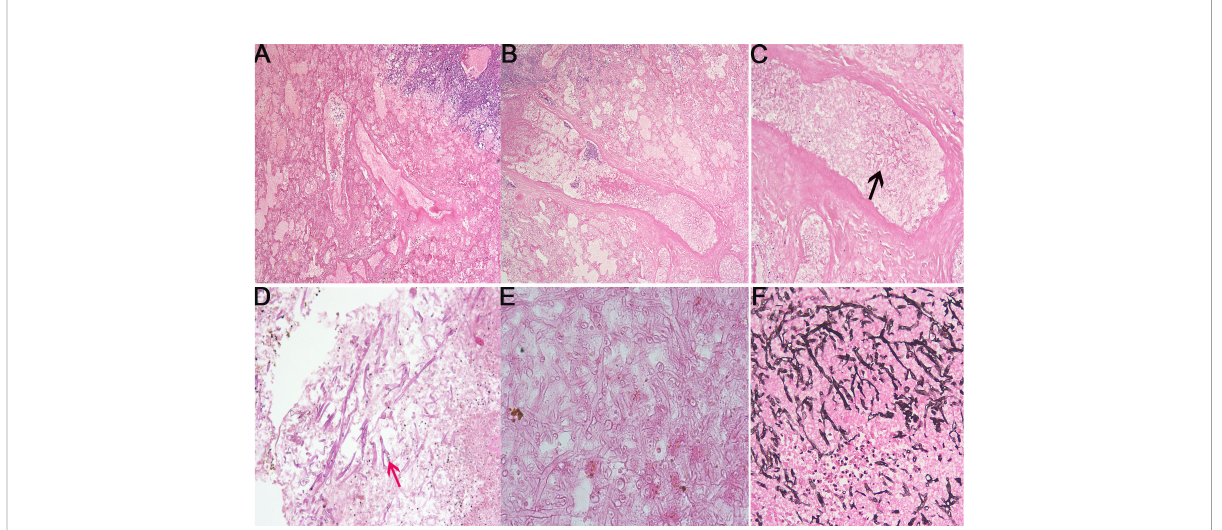
FIGURE 2 Microscopic examination of the removed lung. (A-D) . The tissue specimens were stained with hematoxylin and eosin staining. (A) Tissue necrosis (×40). (B) Tissue necrosis (×200) . (C) Fungal cenobium (black arrow) in the pulmonary alveoli ( ×200 ). (D) Filamentous fungi (red arrow) in the pulmonary ( ×100 ). (E) Filamentous fungi stained by PAS (×200) . (F) Gomori methenamine silver stain of a fungal cenobium (Grocott,